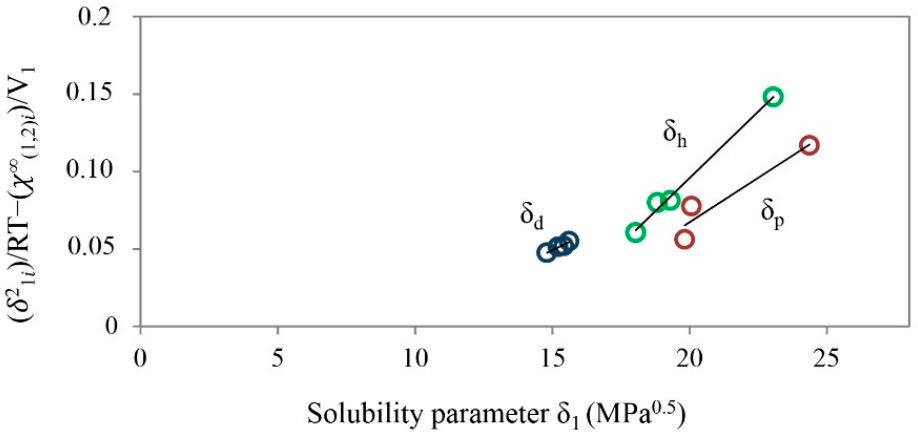
Figure 3. Graph ( δ 21i )/RT − ( χ ∞ (1,2)i )/V 1 for ibuprofen lysinate as a function of total solubility parameter of solvents, δ 1 , at T = 303.15 K; the contribution of δ d is marked in blue color, δ p in red color and δ h in green color.